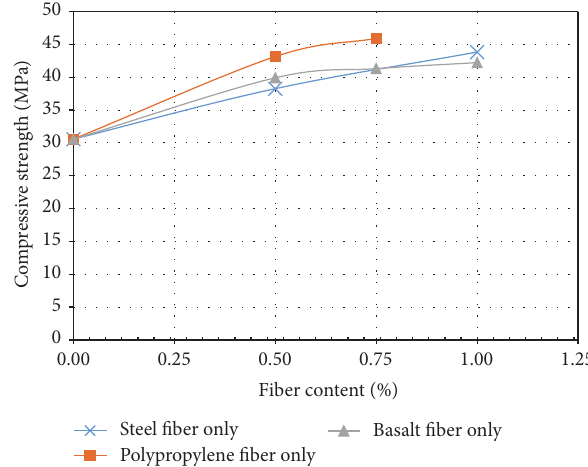
Figure 6: Comparison of compressive strengths in individual fiber mix.